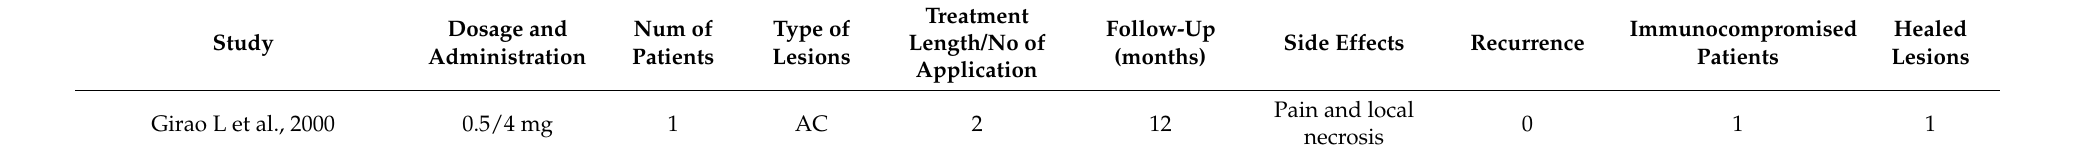
Table 4. Bleomycin